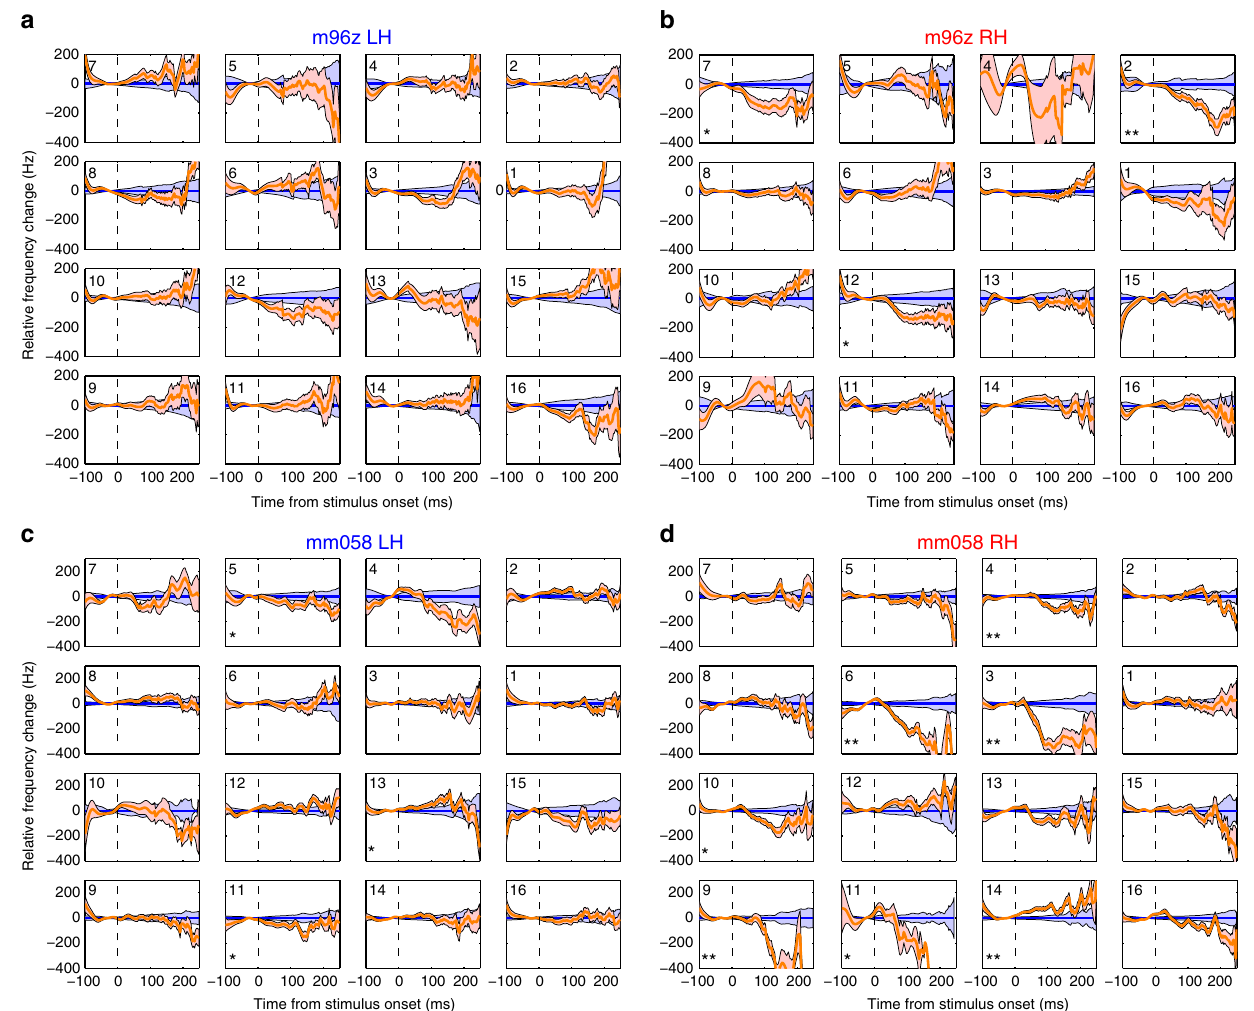
Fig. 8 Additional examples of microstimulation effects by electrode location. a Left and b right hemisphere electrode arrays for animal m96z. c Left and d Right hemisphere electrode arrays for animal mm058. Blue: normal trials; orange: stimulation trials (Error bars: SEM, * p < 0.05, ** p < 0.001,